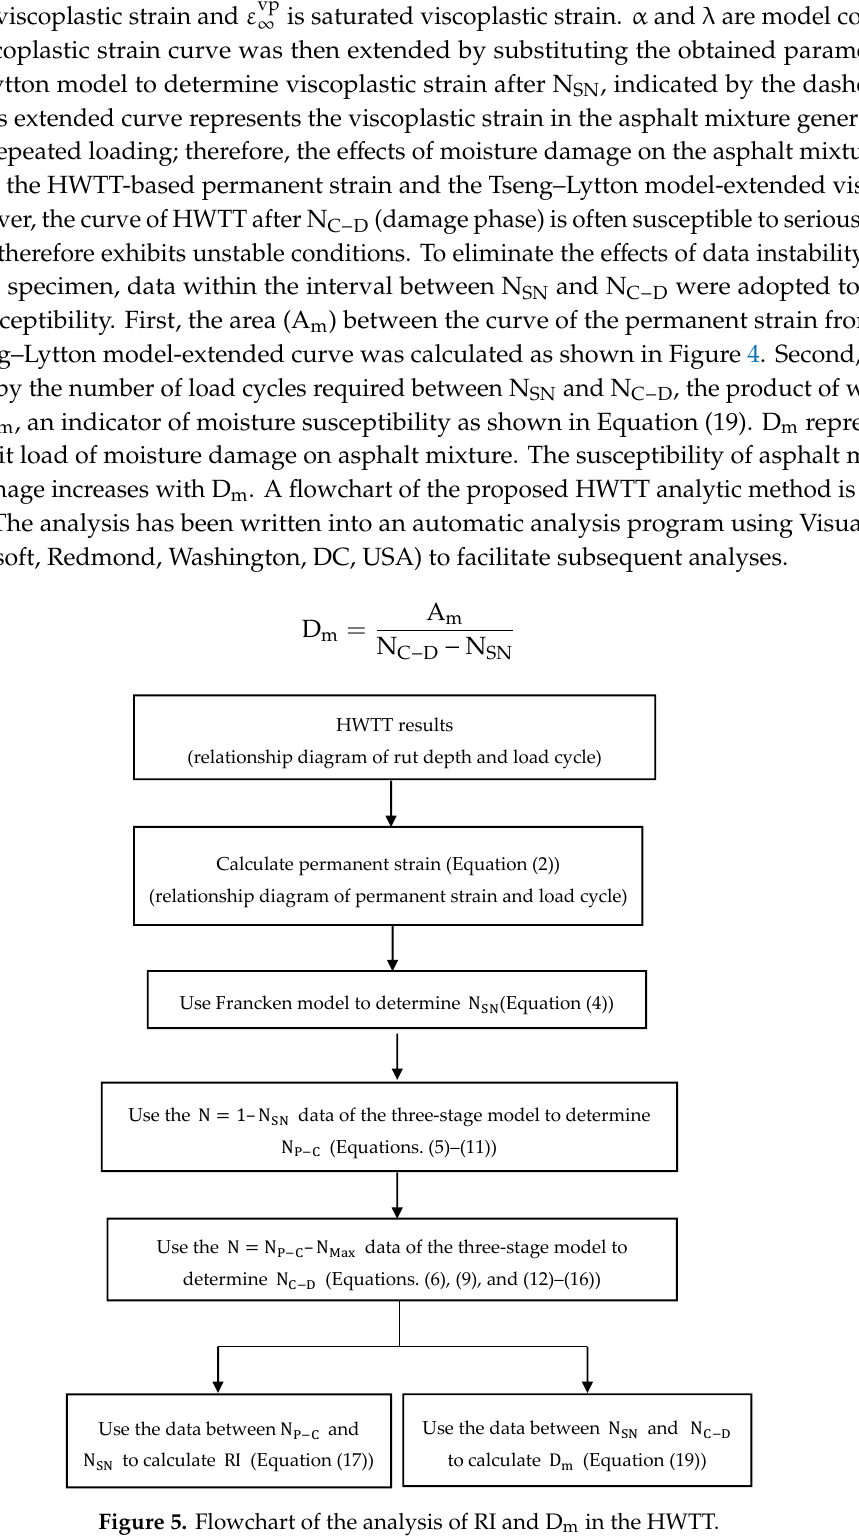
Figure 5. Flowchart of the analysis of RI and D m in the HWTT.